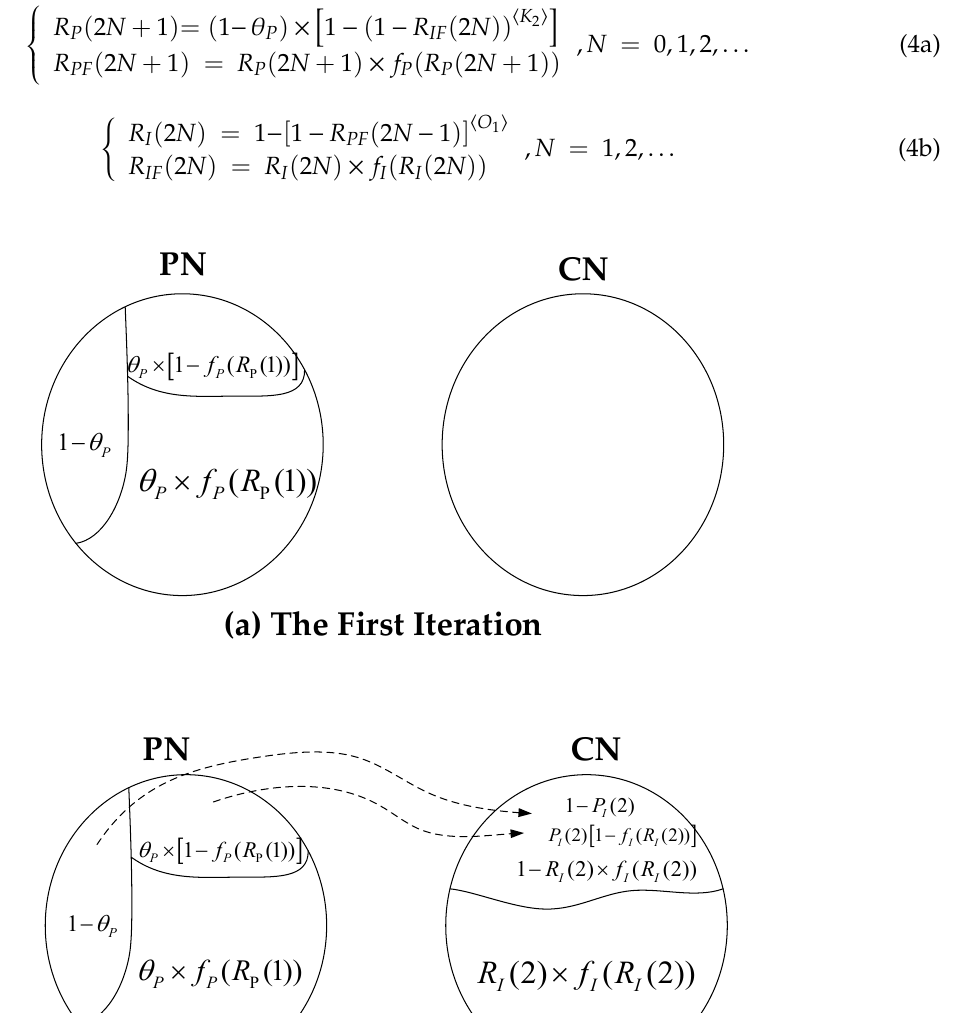
At steady state, the final expected proportions R PF ( ∞ ) and R IF ( ∞ ) of remaining normal operational nodes in the PN and CN are shown in Equation (6).